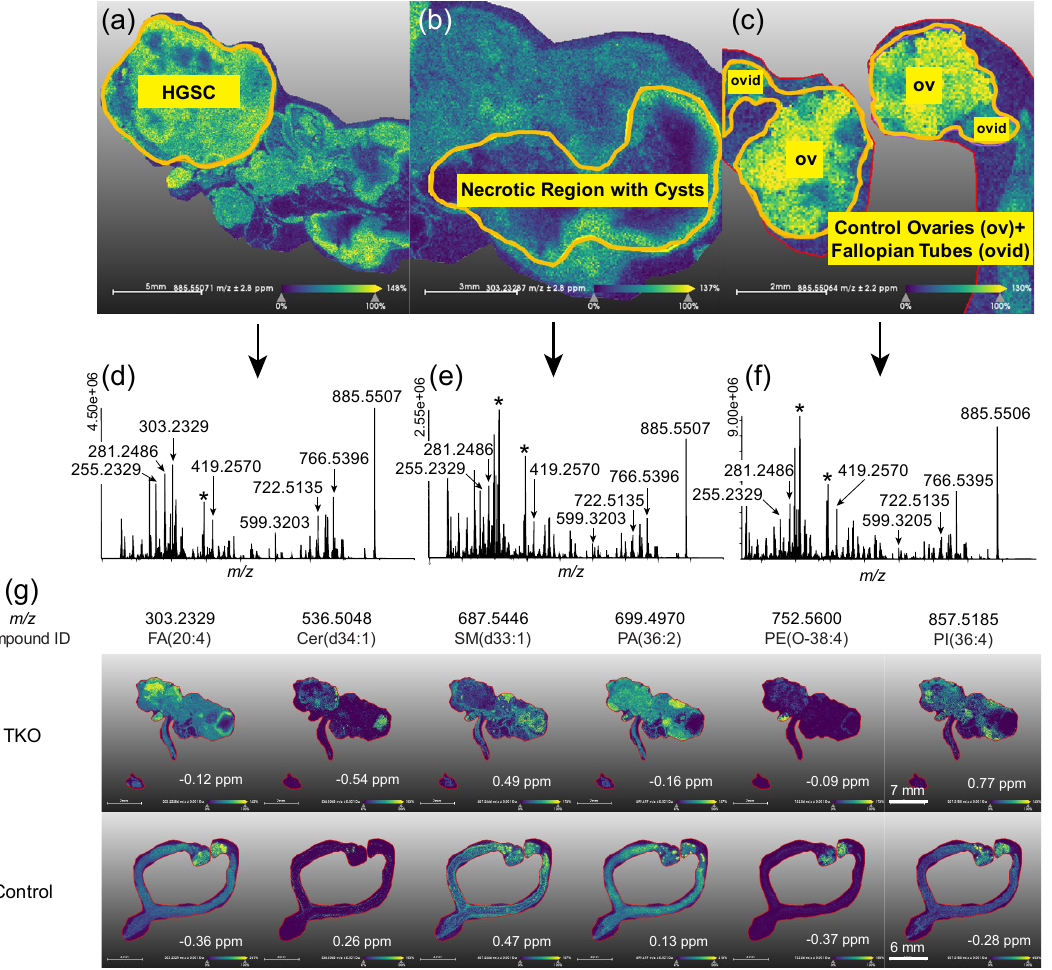
Figure 4. Spatial lipidomics results for specific tissue regions and lipids in TKO and TKO control animals. Average MALDI images of ( a ) HGSC region in TKO animal, ( b ) necrotic TKO tissue region in TKO animal, ( c ) healthy ovaries and fallopian tubes in a TKO control animal. Panels labelled ( d – f ) show the corresponding average negative ion mode MALDI mass spectra. Peaks labelled with asterisks (*) are matrix ions in the background mass spectrum. Panel ( g ) shows MALDI images for selected lipid features in TKO and TKO ctrl tissues. The mass errors for the monoisotopic [M − H] − ions are listed at the bottom right of each image. All the ions’ signals were normalized to the total ion current in each image. The mass window used for creating selected ion images was ±0.001 Da.